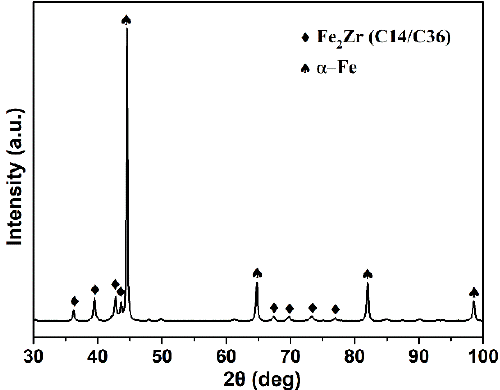
Figure 1. XRD patterns of the Fe-Cr-Zr alloy.